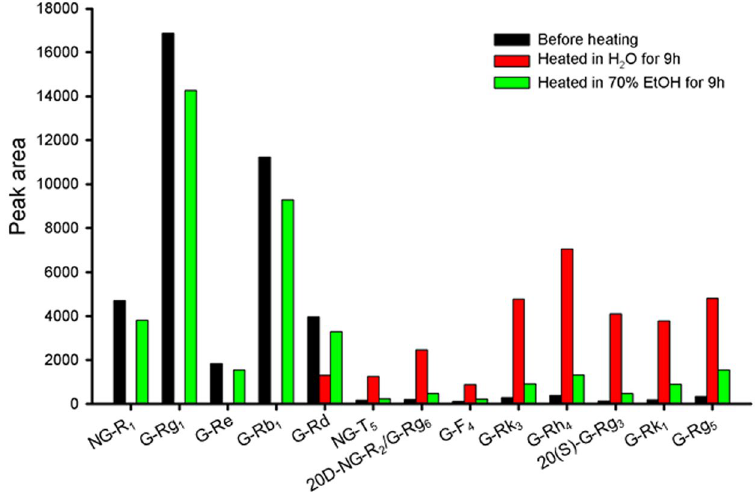
Figure 7. Proportions variations of constituents in accelerated degradation